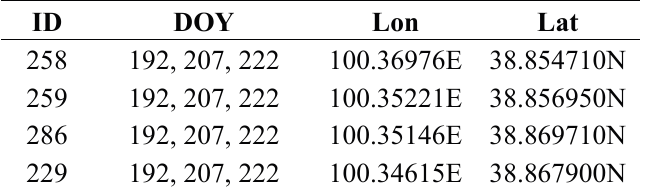
Table 2. Information on the measured points used to constrain the input parameters.